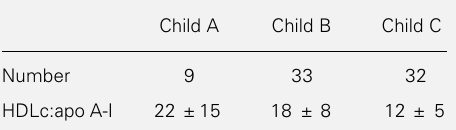
Table 4 - HDLc:apo A-I ratio in patients with chronic liver failure according to the Child classification. P<0.05 between the Child A and C, and B and C groups (Student t